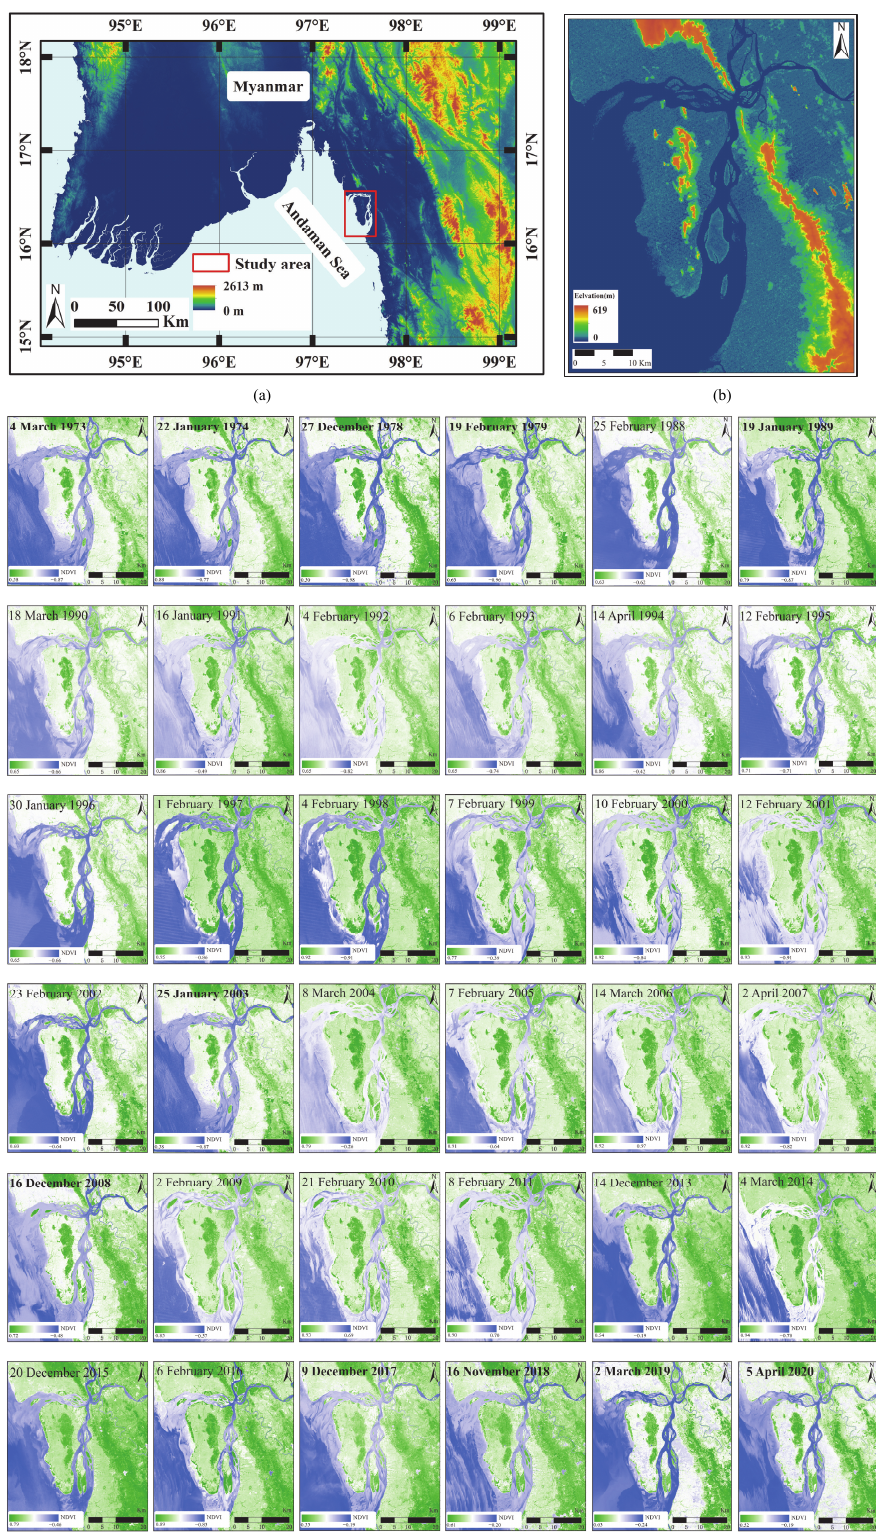
Figure 1. Study area location ( a ) DEM ( b ) and NDVI image series (Terrain data based on SRTM downloaded from